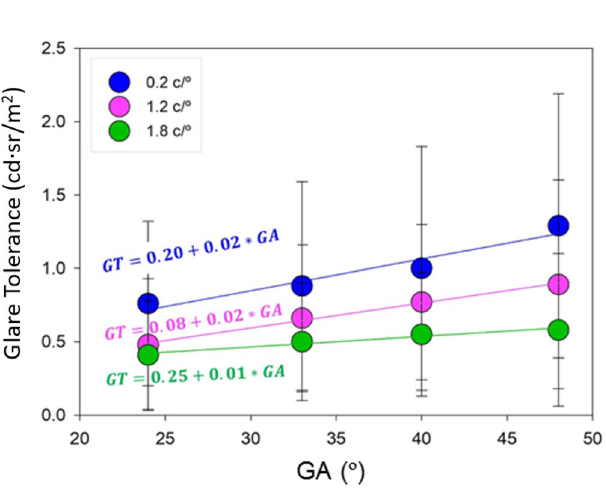
Figure 2. Graphical representation of the GT parameter as a function of angular size of the glare source and linear regression for spatial stimulus frequencies of 0.2 (blue), 1.2 (purple) and 1.8 c/° (green).